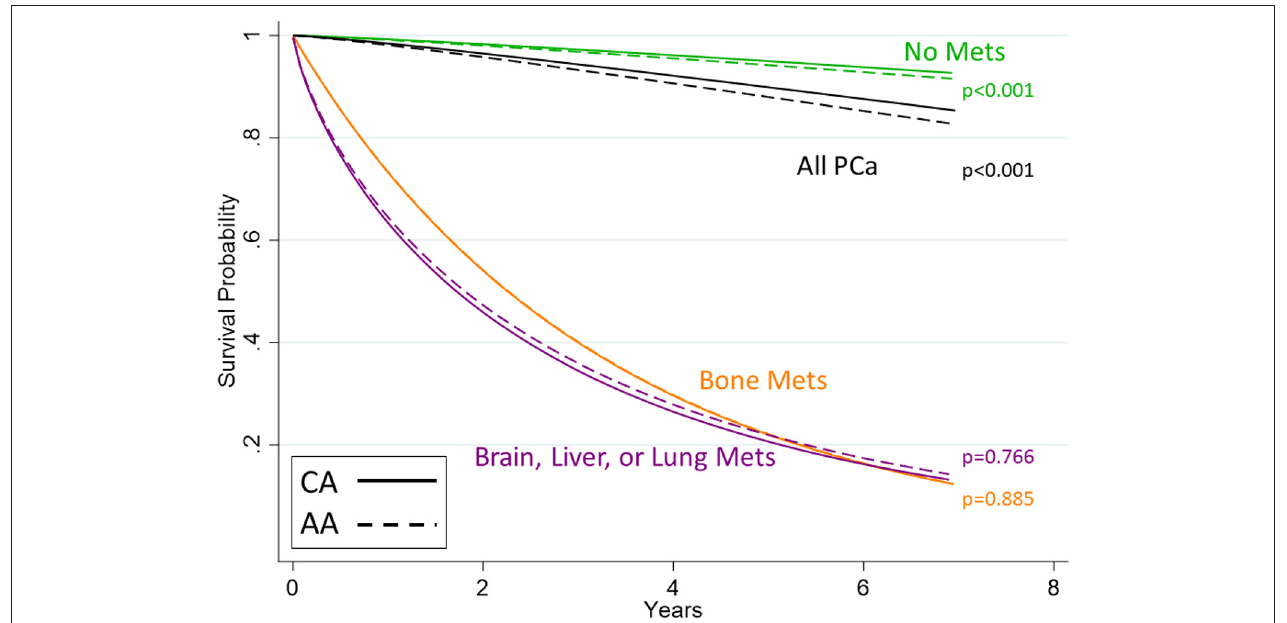
FIGURE 1 | Survival curves for men with prostate cancer stratified by metastasis category. Shown are curves estimated from Weibull models. Whites are shown with solid lines and African Americans with dashed lines. The black line shows all PCa diagnoses, regardless of metastases status. Of note is that the lines representing racial distinctions are indistinguishable for the bone metastasis group (orange) since the African American effect contributes virtually nothing to the hazard of death ( p = 0.885) nor for metastasis other than bone (purple, p = 0.766). This null effect was not observed in the group with no metastasis ( p < 0.001, green